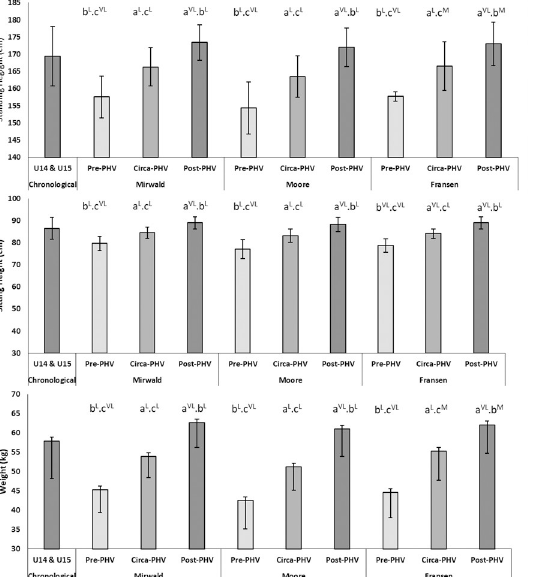
Fig 1. Comparison of mean values (+/ SD) between chronological (U14 & U15) and bio-banded maturity groups for anthropometric (stature, sitting height and body-mass) with effect sizes for between maturity status group (a—’pre- PHV’; b—’circa-PHV’; c–‘post-PHV) magnitude. Effect Sizes: T–Trivial, S–Small, M–Moderate, L–Large, VL–Very Large; Trivial < 0.2, Small 0.2–0.6, Moderate 0.6–1.2, Large 1.2–2.0, Very Large > 2.0